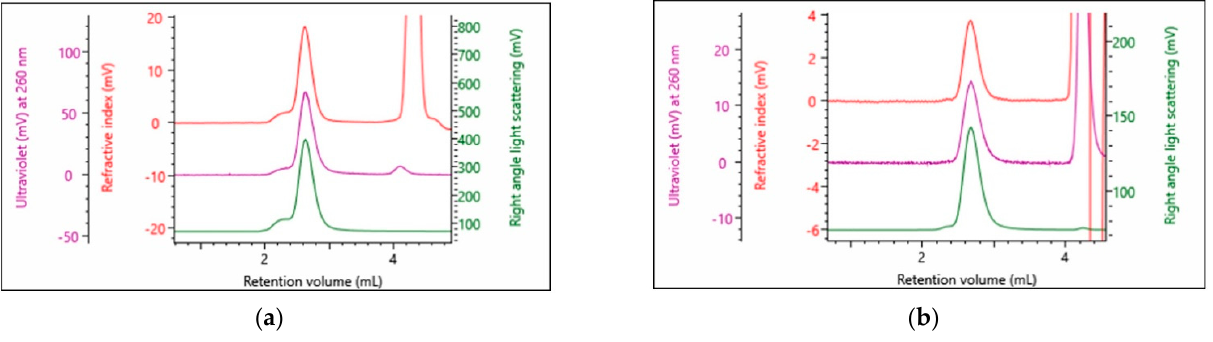
Figure 6. Multi-detection chromatogram of the different serotypes as separated on a Sepax SRT 500 and analyzed on an OMNISEC system: ( a ) rAAV9 (full); ( b ) rAAV2 (full).